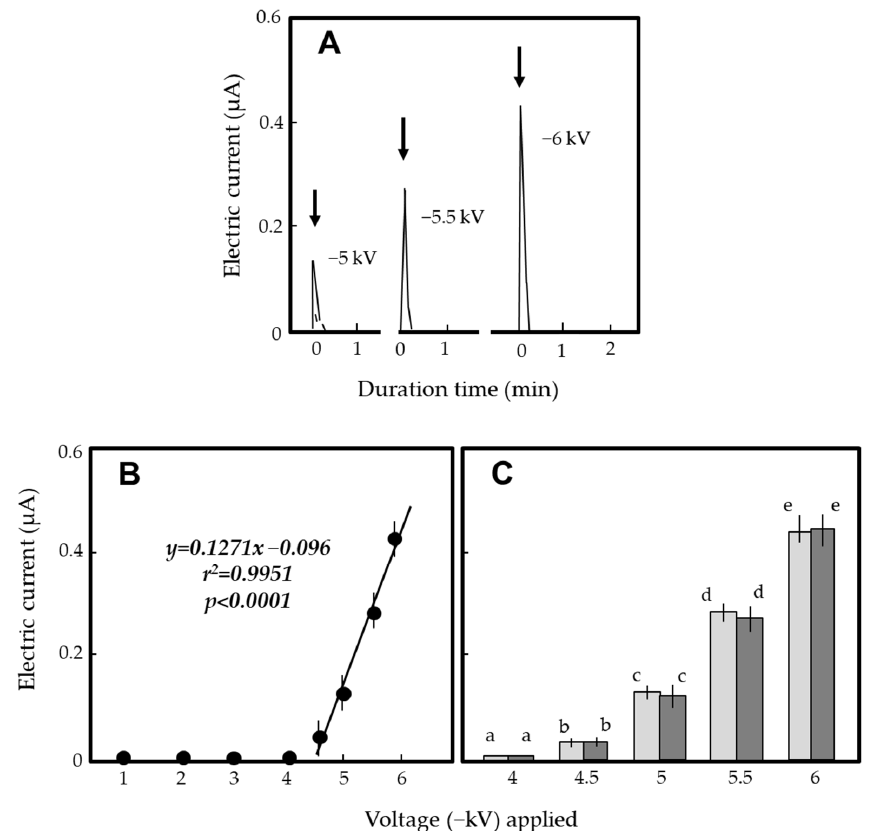
Figure 2. ( A ) Profiles of transient electric currents from discharges of adult female Turkestan cockroaches that inserted their antennae into the static electric field of the S-EFP negatively charged with different voltages. ( B ) Relationship between the applied voltage and magnitude of the transient electric current. ( C ) Difference in the magnitude of the electric current between adult male (left) and female (right column) cockroaches. Twenty insects were used per voltage. The means and standard deviations were calculated from five repetitions of the experiments. The letters (a–e) attached to the columns indicate significant differences ( p < 0.05) according to Tukey’s method.